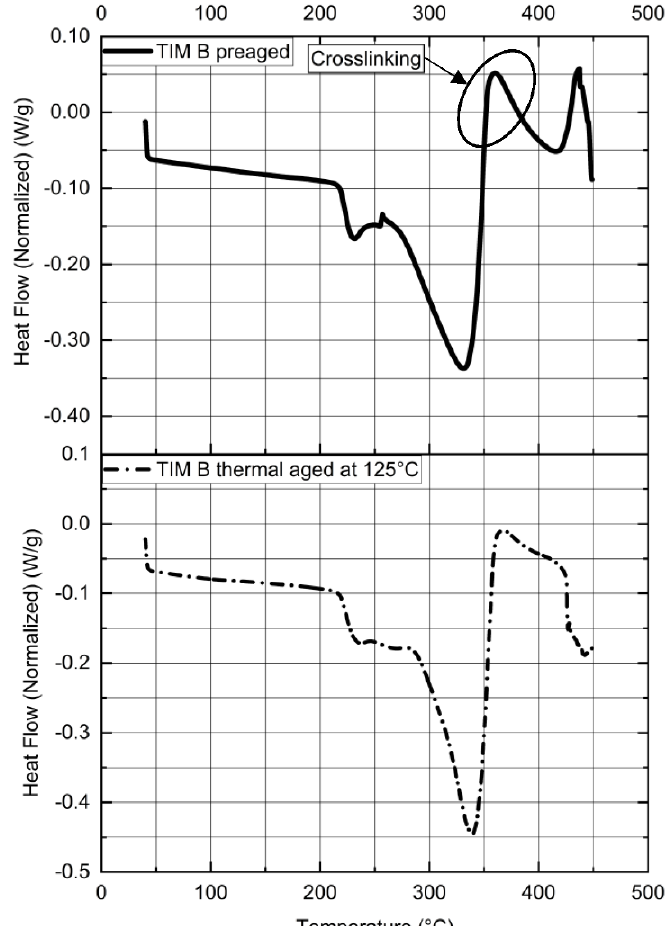
Figure 15. Normalized heat flow vs. temperature of TIM B.